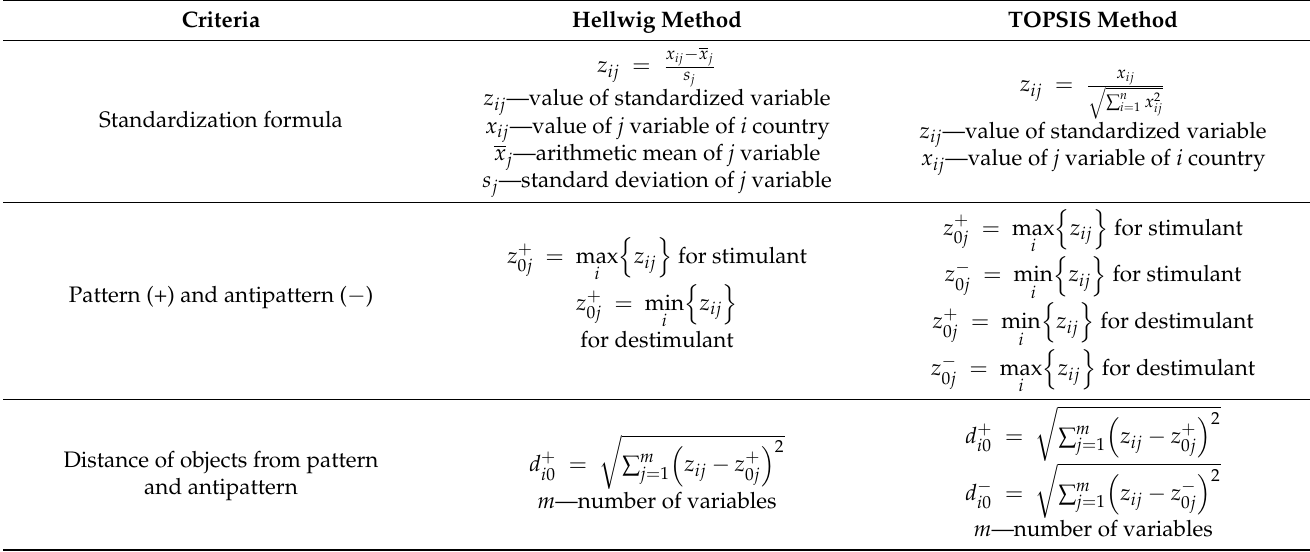
Table 3. Applied